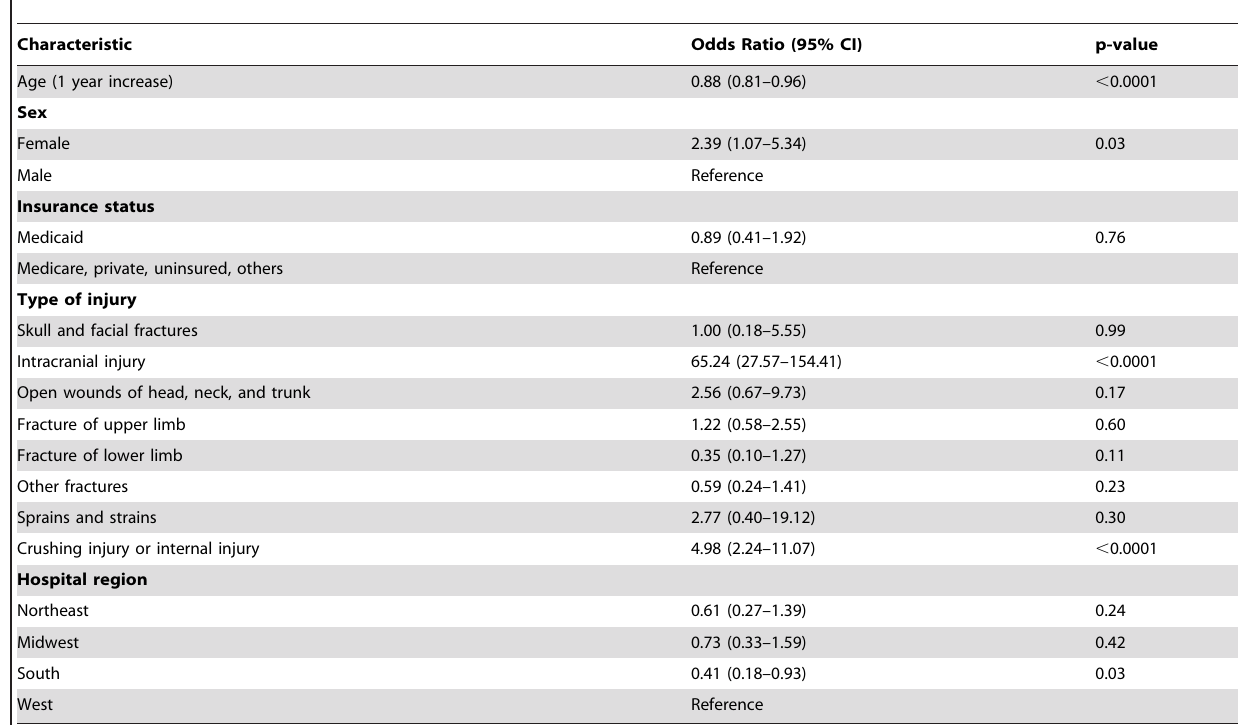
Table 6. Characteristics associated with hospital mortality (multivariable logistic regression